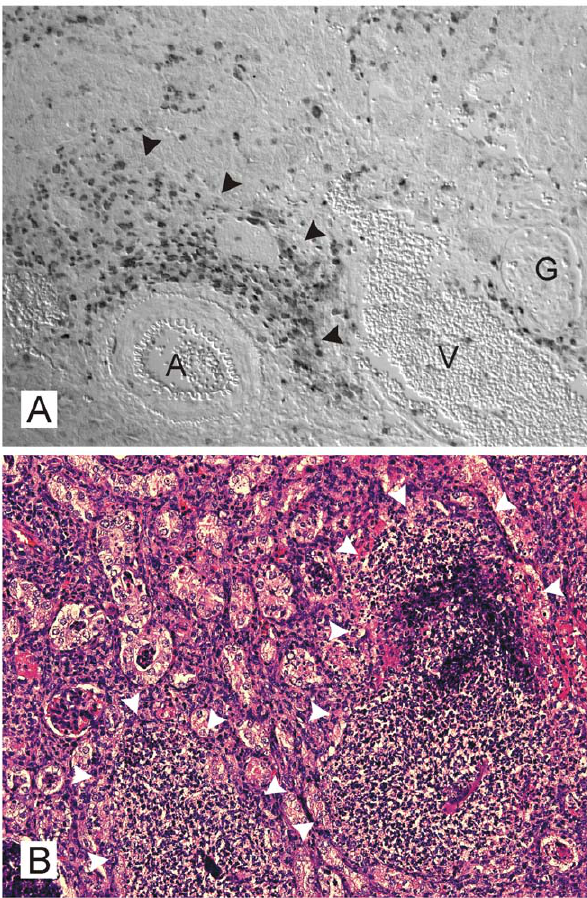
Figure 8. HIF-1 activation in kidneys of mice infected with S. aureus . (A) HIF 1 a immunohistochemistry and (B) hematoxilin-eosin staining of renal mouse abscesses induced by intravenous infection with S. aureus seven days upon infection (following sections). HIF 1 a positive nuclei are most abundant within the abscesses borders, some interstitial staining also occurs within the renal parenchyma. In addition, renal tubules in the vicinity of the abscess stain also positively (halfed arrow in B). A: arcuate artery, G: glomerulus, V: arcuate vein; arrowheads: margin of abscesses. Magnifications: (A) 250 6 , (B) 100 6 . doi:10.1371/journal.pone.0011576.g008 [30] and respiratory syncytial virus (RSV) [31]. Using bacterial